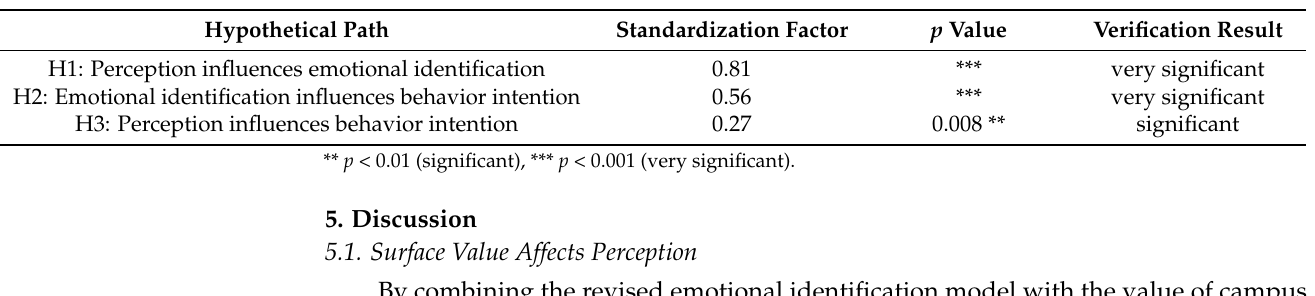
Table 6. Model path and verification.